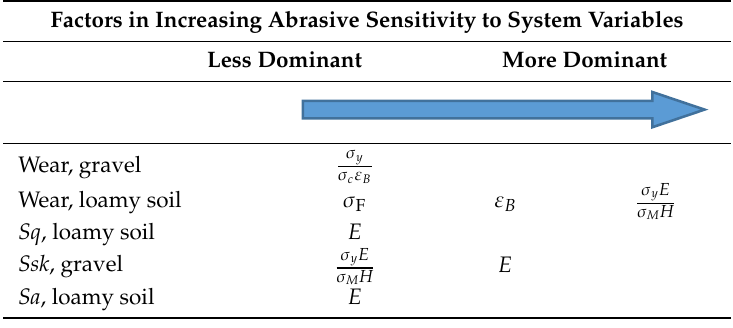
Table 12. Ranking the abrasive sensitivity to slurry system features. Table 9. Ranking the abrasive sensitivity to the system